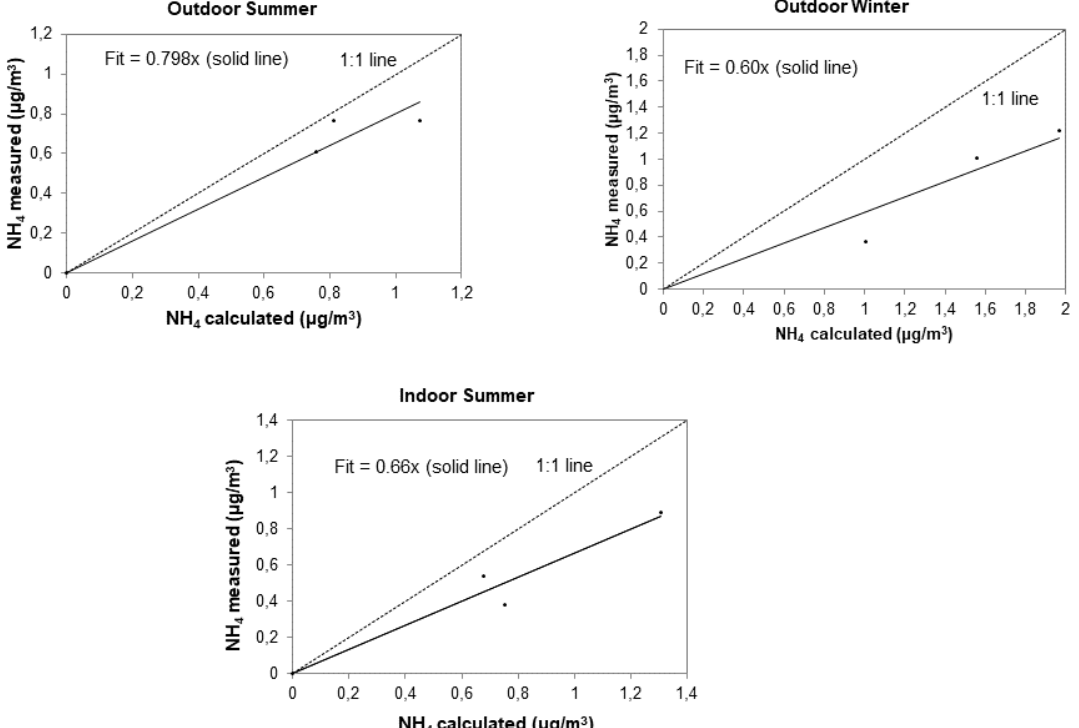
+ ] meas in relation to [NH + Figure 5. [NH 4